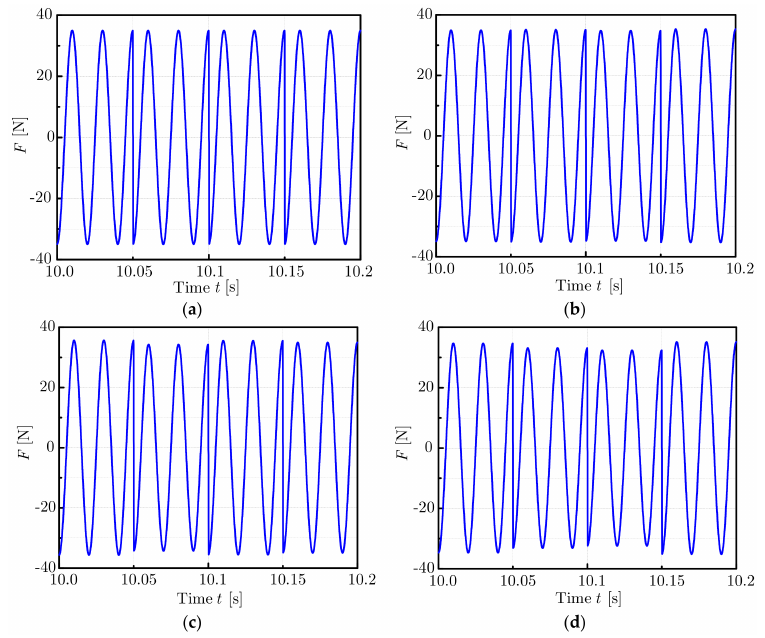
Figure 4. Sealing force under the ideal and three other randomly uncertain states, where ( a ) is the ideal results and ( b – d ) are the results with δ R = 0.02,0.08,and0.20,